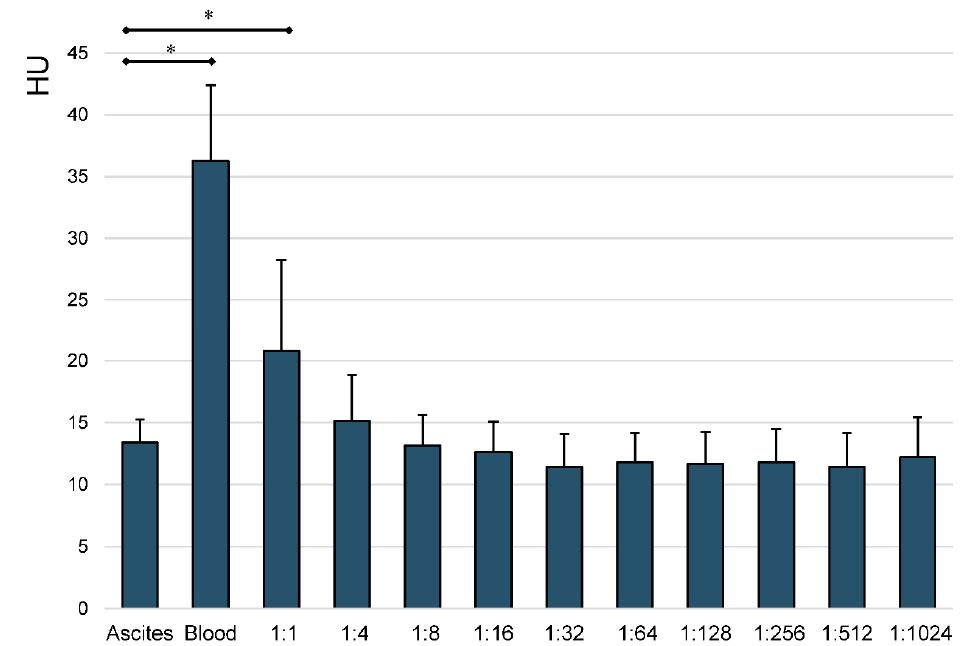
Figure 4. Mean HU measurements of ascites, blood and all steps of the prepared serial dilutions. Whiskers represent standard deviations. Significant differences (* p < 0.05) are designated by asterisks.